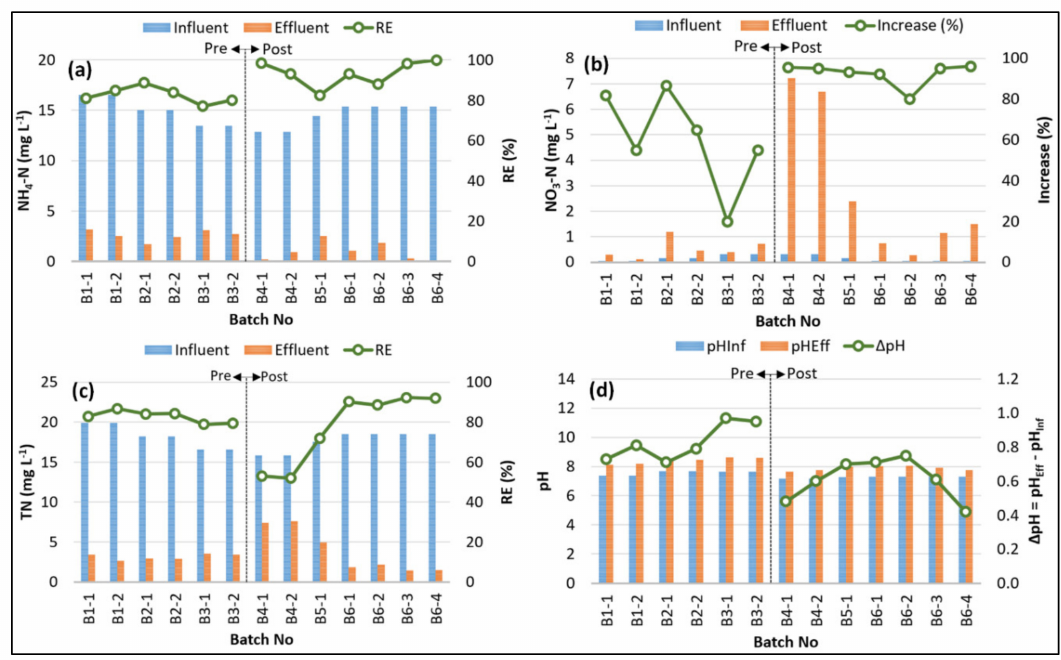
Figure 2. Variations of ( a ) nitrogen (NH 3 –N), ( b ) nitrate-nitrogen (NO 3 –N), ( c ) total nitrogen (TN), and ( d )